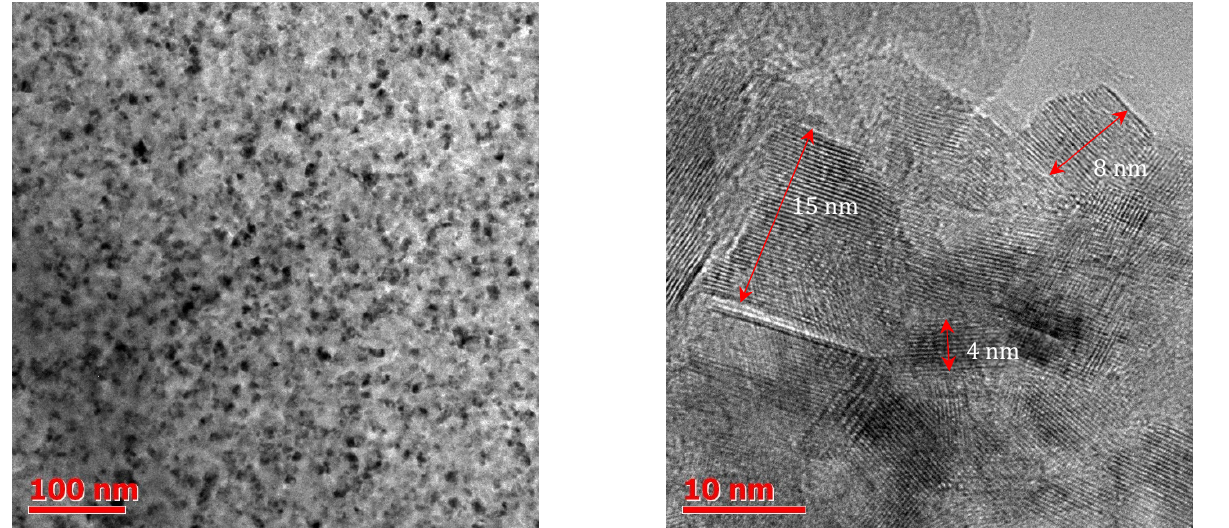
Figure 3. Homogeneous BNNSs with an average size of 10 nm synthesized by one-stage low-temperature ammonolysis of boric acid (ammonothermal dehydration method).